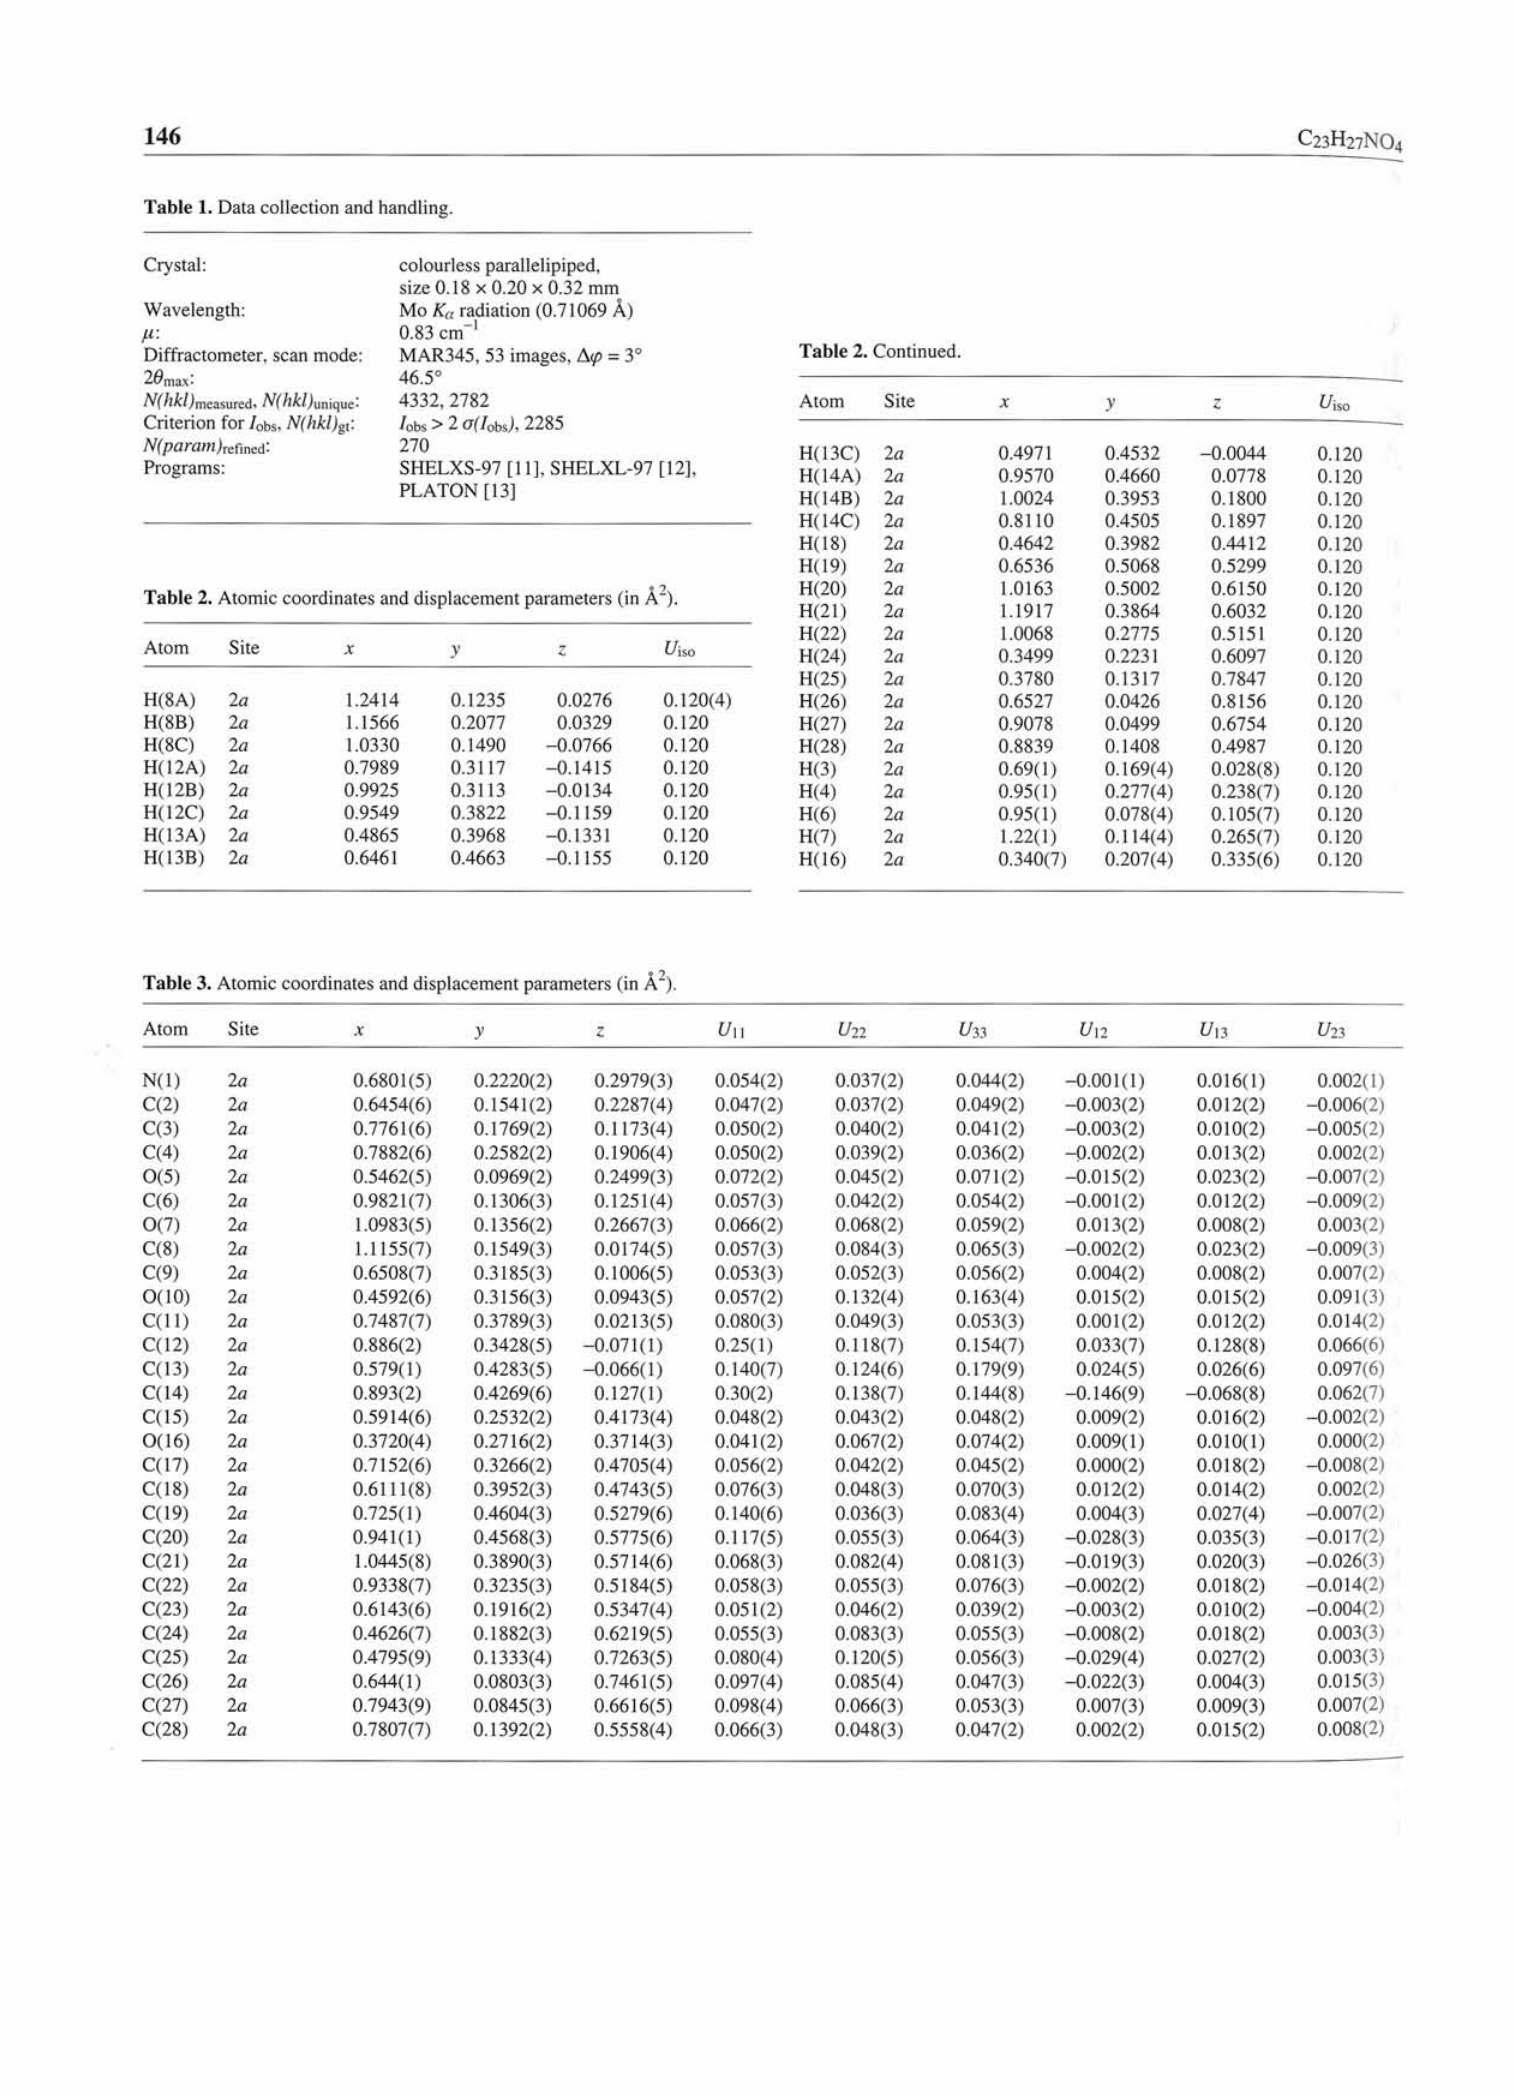
Table 2. Atomic coordinates and displacement parameters (in A ).